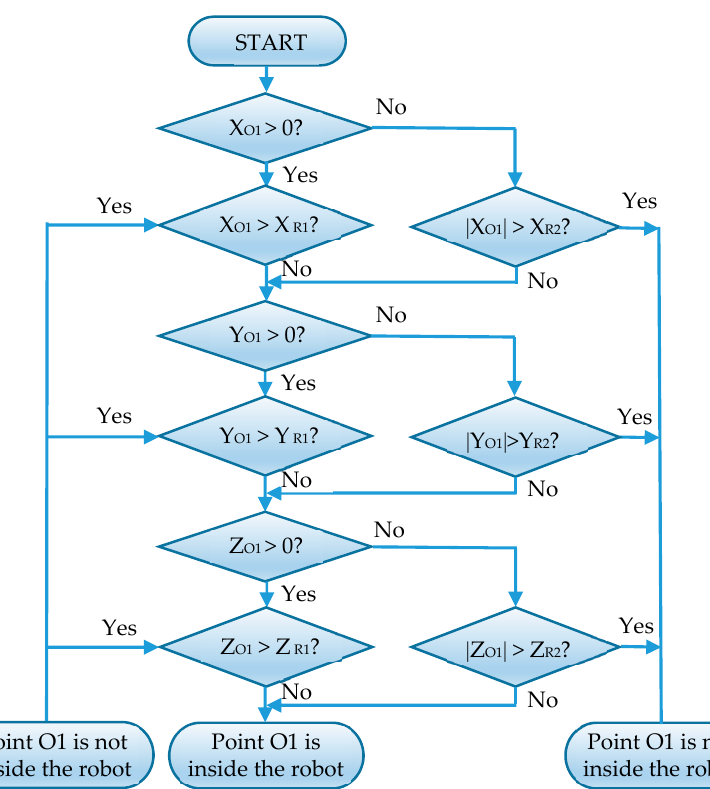
Figure 20. Detection results filtration flowchart.